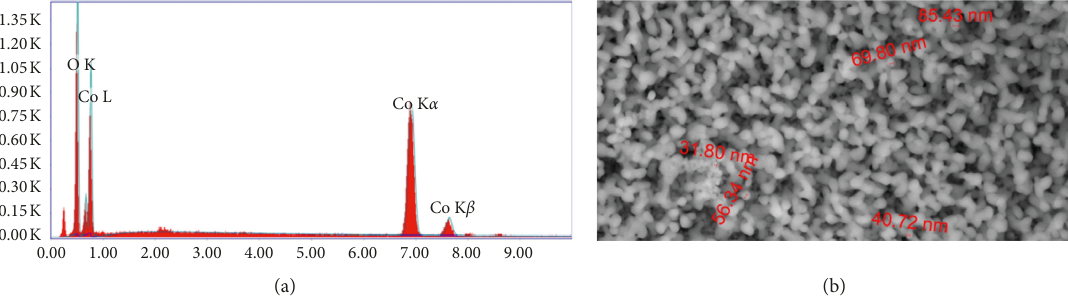
° starting from cobalt glutamic arginine mixed